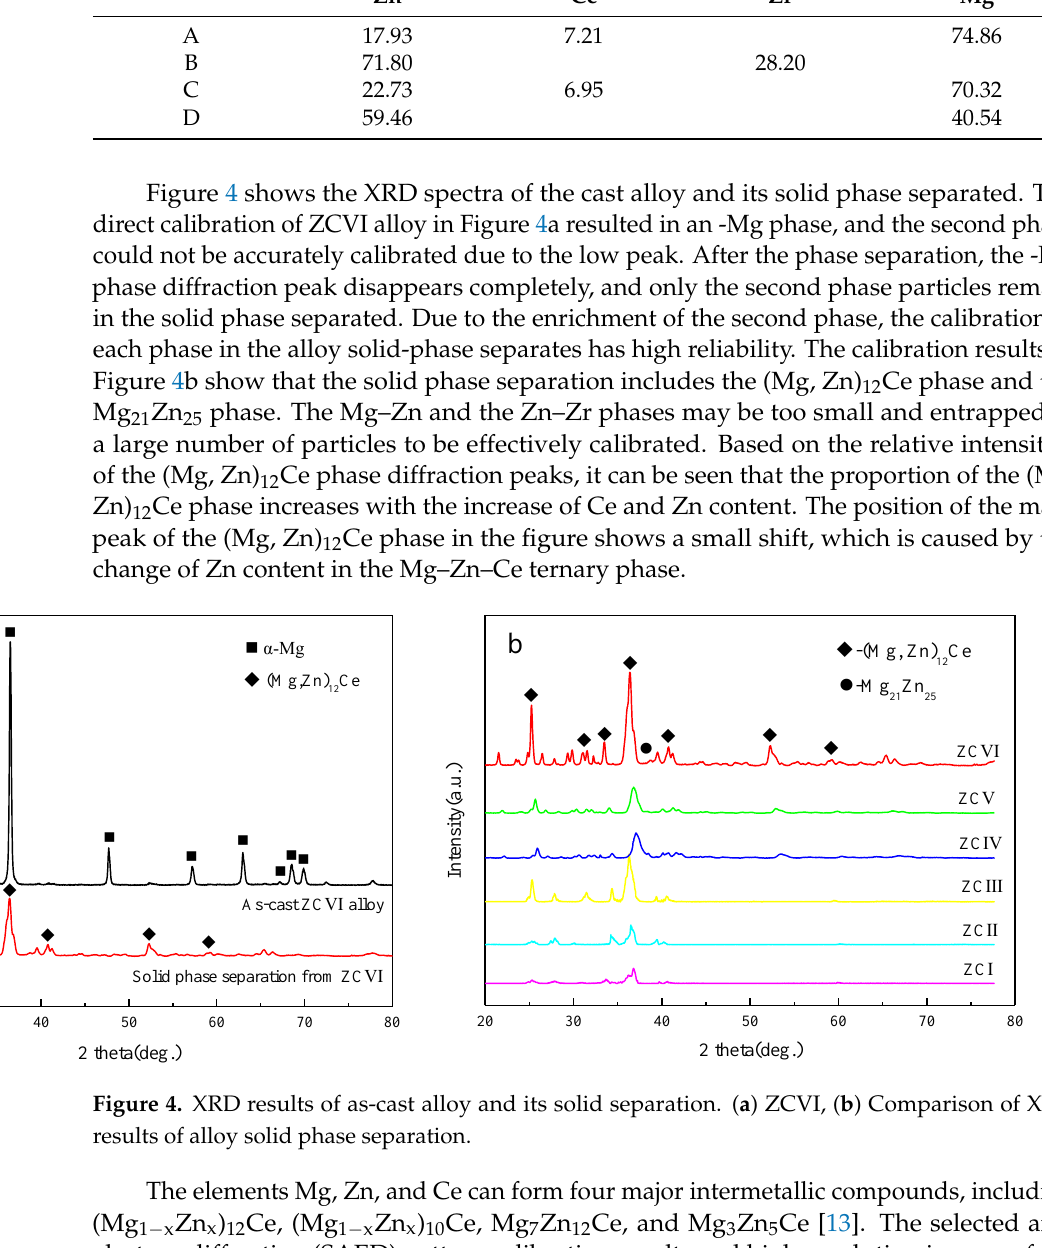
Table 2. EDS Analysis Results of Typical Alloy Solid Phase Separation.